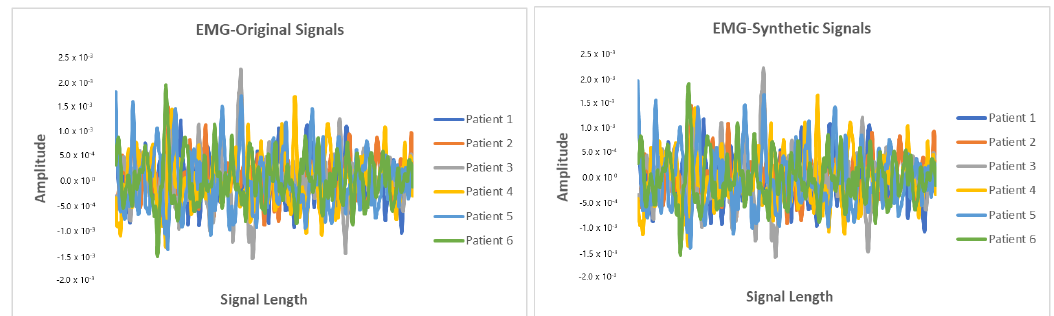
Figure 11. Comparison between original and synthetic EMG